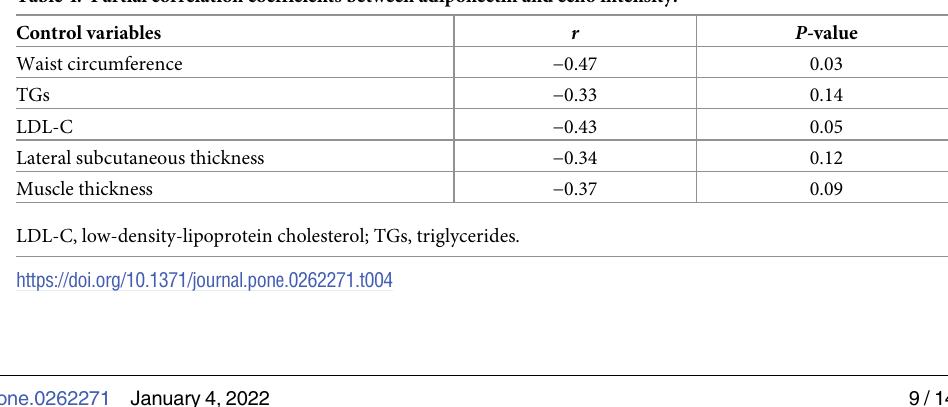
Table 4. Partial correlation coefficients between adiponectin and echo